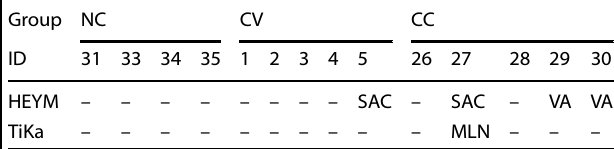
Negative results with “–“ symbol; positive results show with abreviations indicating the sample tissue: Sacculus rotundus (SAC), vermiform appendix (VA), mesenteric limph node